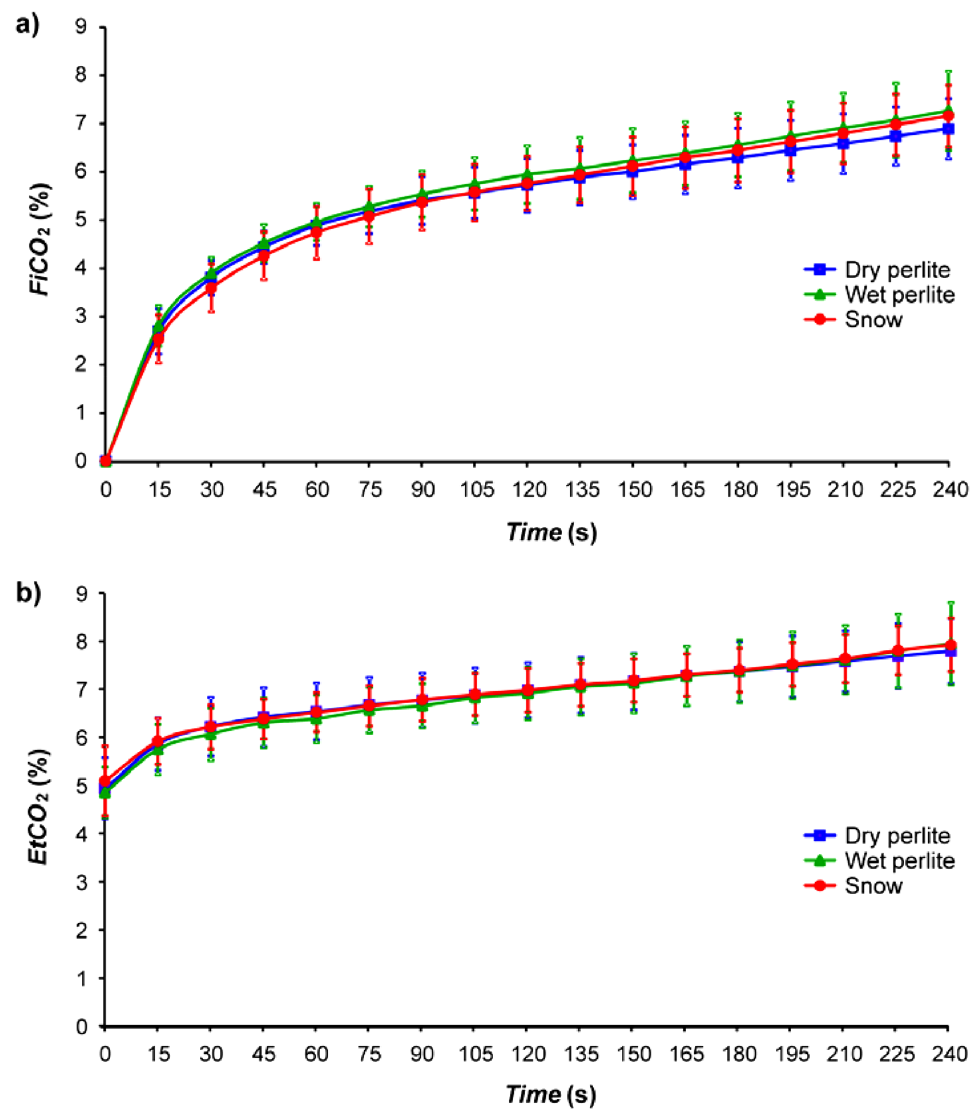
Figure 6. Inspiratory fractions of carbon dioxide ( FiCO 2 ) in a) and end-tidal fractions of carbon dioxide (